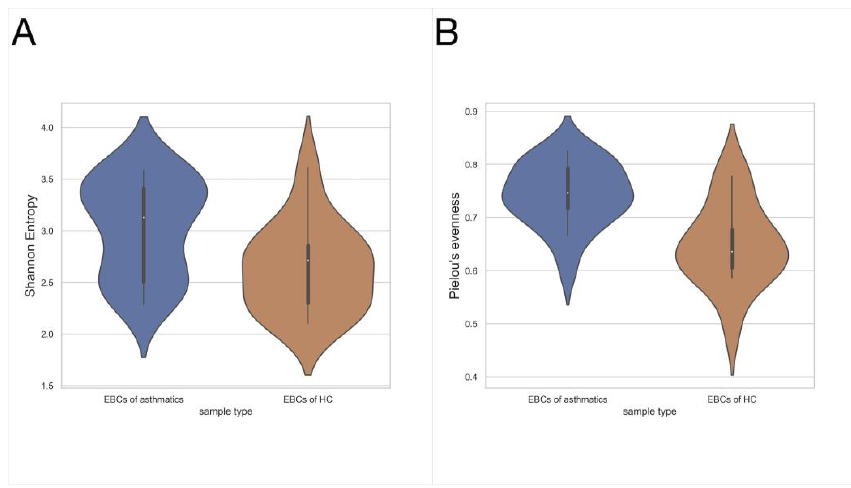
Figure 3. Alpha diversity metrics for EBC, asthmatic patients vs. healthy controls. ( A ) Shannon diversity index, mean 3.029 (±0.462) vs. 2.642 (±0.424), p = 0.026; ( B ) Pielou’s evenness, mean 0.742 (±0.060) vs. mean 0.648 (±0.078), p = 0.002; asthmatics ( n = 19) vs. control ( n = 14), respectively, Kruskal–Wallis test.